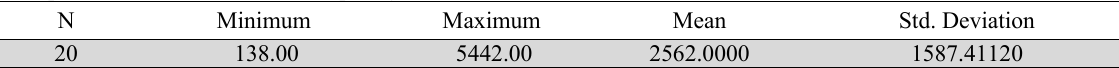
Descriptive Statistics Data on the frequency of natural disasters in Indonesia N Minimum Maximum Mean Std. Deviation 20 138.00 5442.00 2562.0000 1587.41120